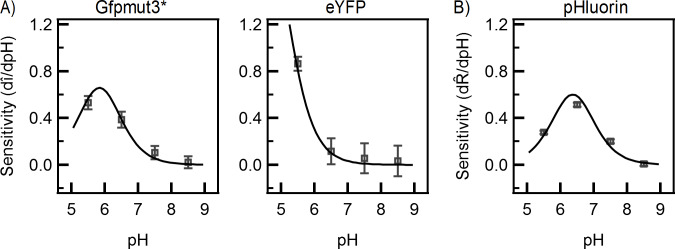
Fluorophore sensitivity versus pH.The experimental sensitivities (indicated by symbols) were calculated for the medium expression level case (10 μM IPTG) for each type of fluorescent protein. The solid lines indicate model predictions based on the K-values for the respective fluorophores (Fig 3). eYFP exhibited the highest sensitivity among the three fluorescent proteins. Gfpmut3* and pHluorin exhibited similar sensitivities and peaked between pH 6.0–6.5. Error bars were determined by error propagation.